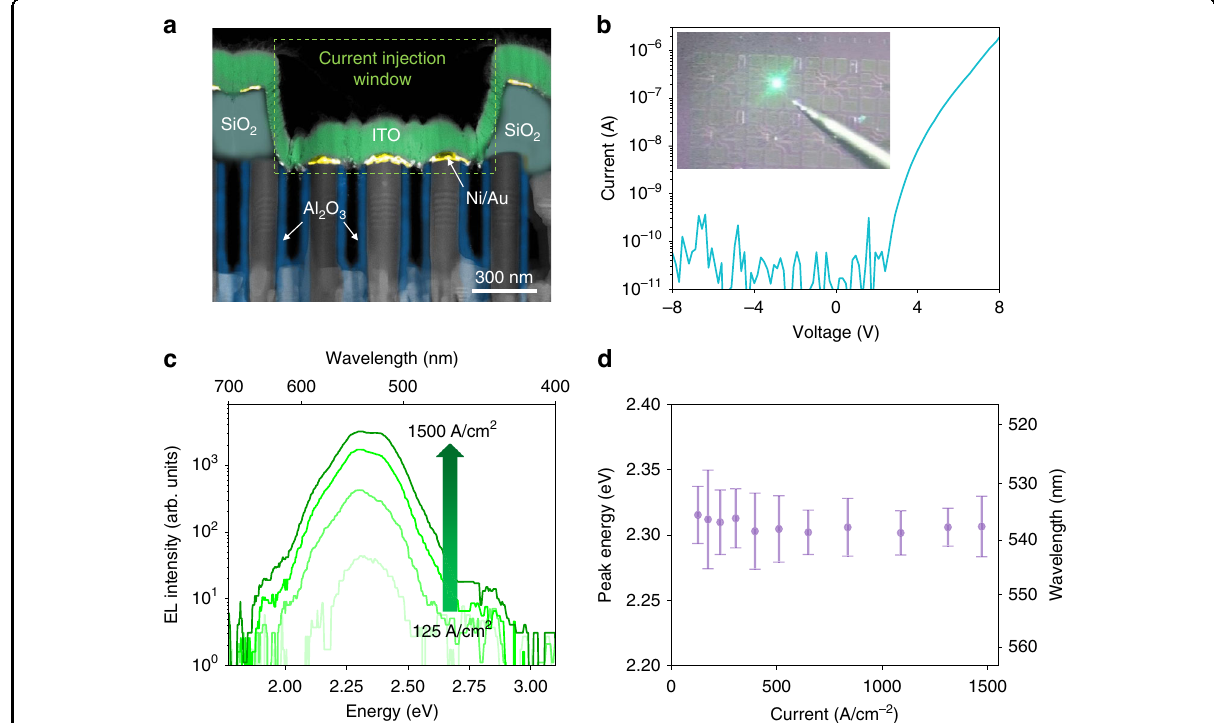
Fig. 5 Performance characteristics of an InGaN µLED on Si. a Cross-sectional HAADF-STEM image of the as-fabricated InGaN/AlGaN μ LED with an areal size of ~900 × 900 nm 2 . The current injection window is delineated by the green dashed box. Blue false color is applied to the Al 2 O 3 passivation layer and the dark-cyan false color is assigned to the SiO 2 insulation layer. Ni/Au layer is depicted by yellow false color and ITO is depicted by green false color. b I-V characteristics of as-fabricated InGaN/AlGaN nanowire μ LEDs at room temperature, wherein negligible leakage current is observed at reverse bias. Inset: an optical image of the bright green emission measured from a µLED under an injection current of ~100 A·cm − 2 . c EL spectra under injection currents from 125 to 1500 A·cm − 2 for an InGaN/AlGaN μ LED. d Variation of peak position vs. injection